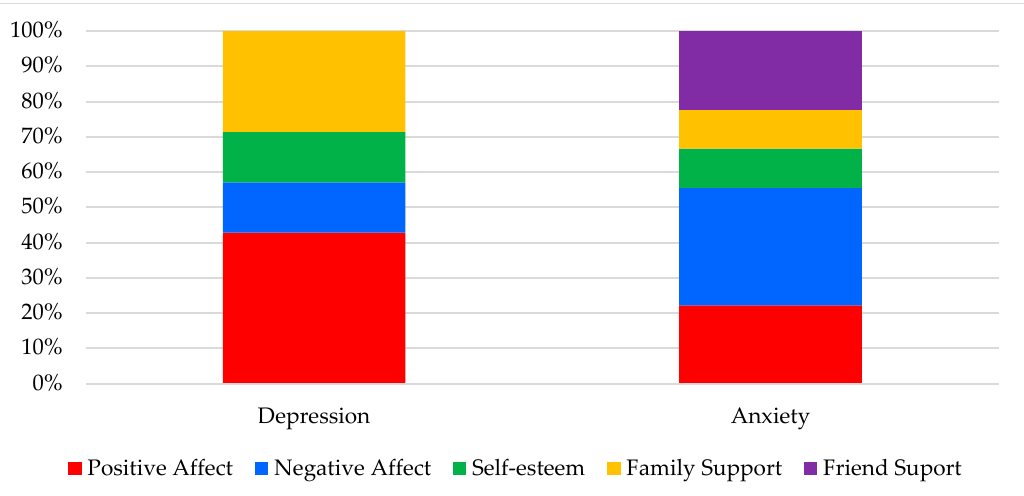
Figure 1. Differential participation of positive affect, negative affect, self ‐ esteem, family support, and friend support in predicting depression and anxiety scores, taking into account the three multiple regression analyses.